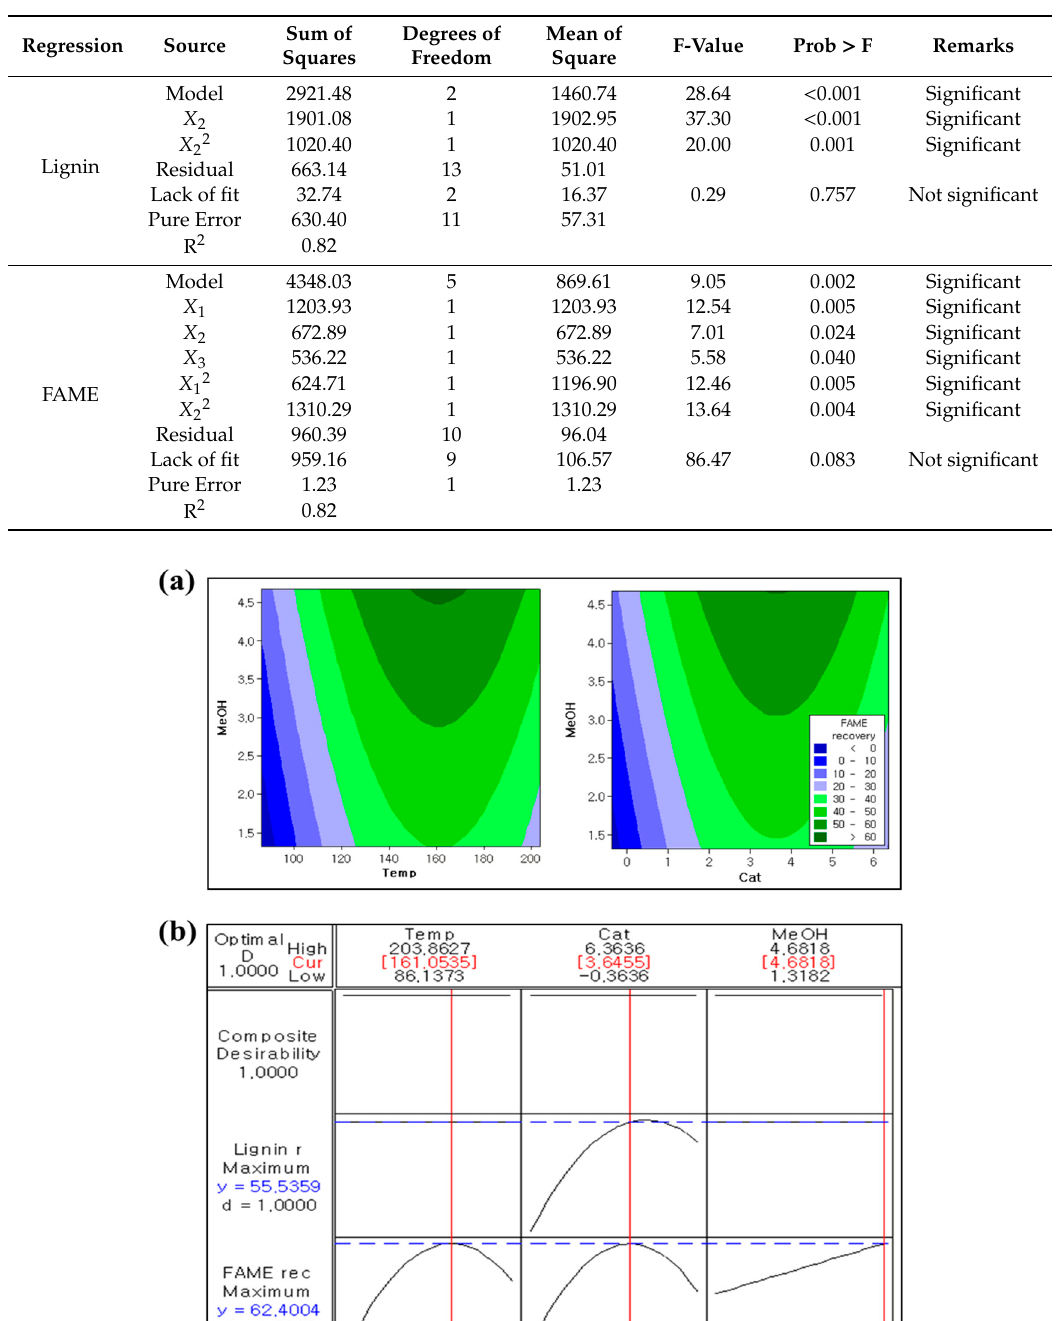
Table 3. ANOVA for the fitted model of recovery of lignin and FAME.